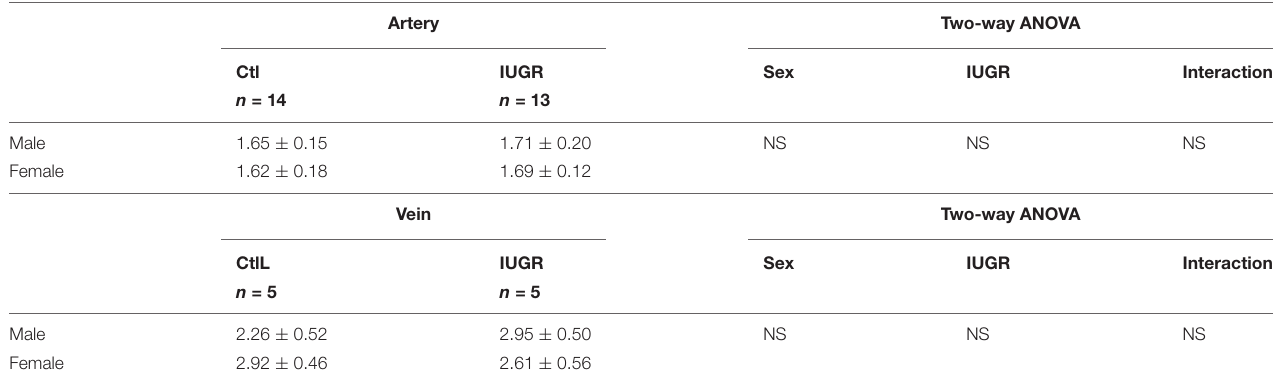
TABLE 1 | Stiffness (B) parameter of artery and vein from control and IUGR fetuses. Artery Two-way